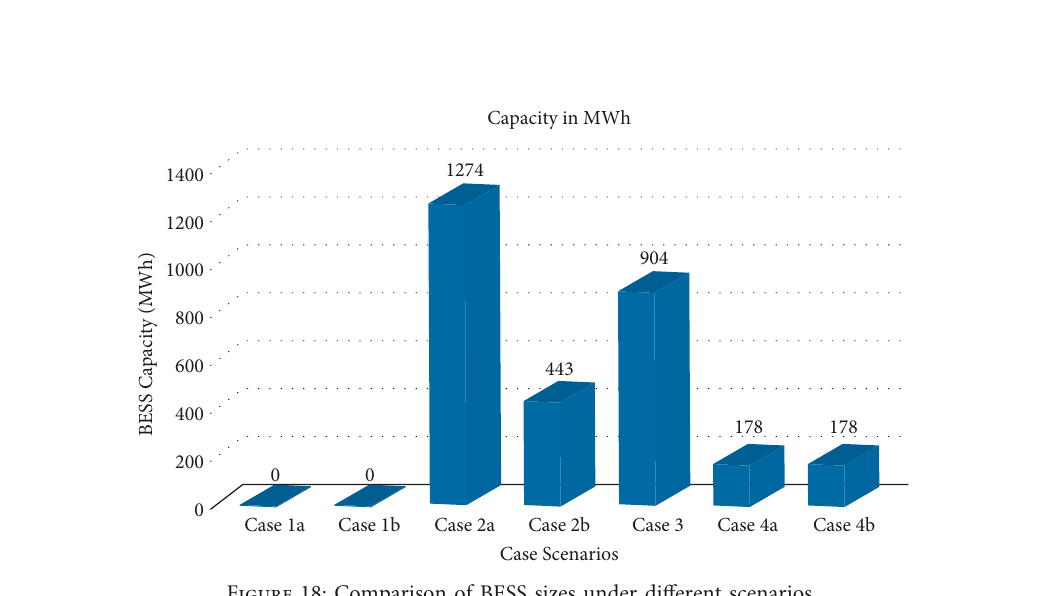
Figure 18: Comparison of BESS sizes under different scenarios.